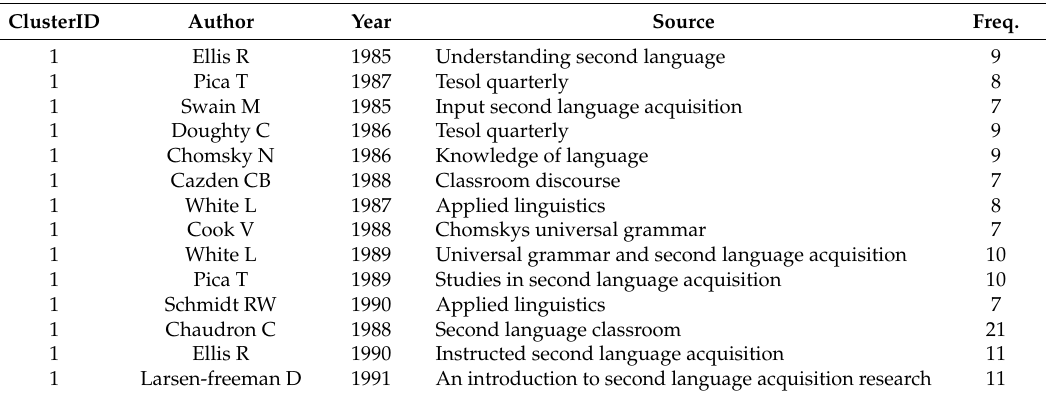
Table 3. The members of Cluster #1.